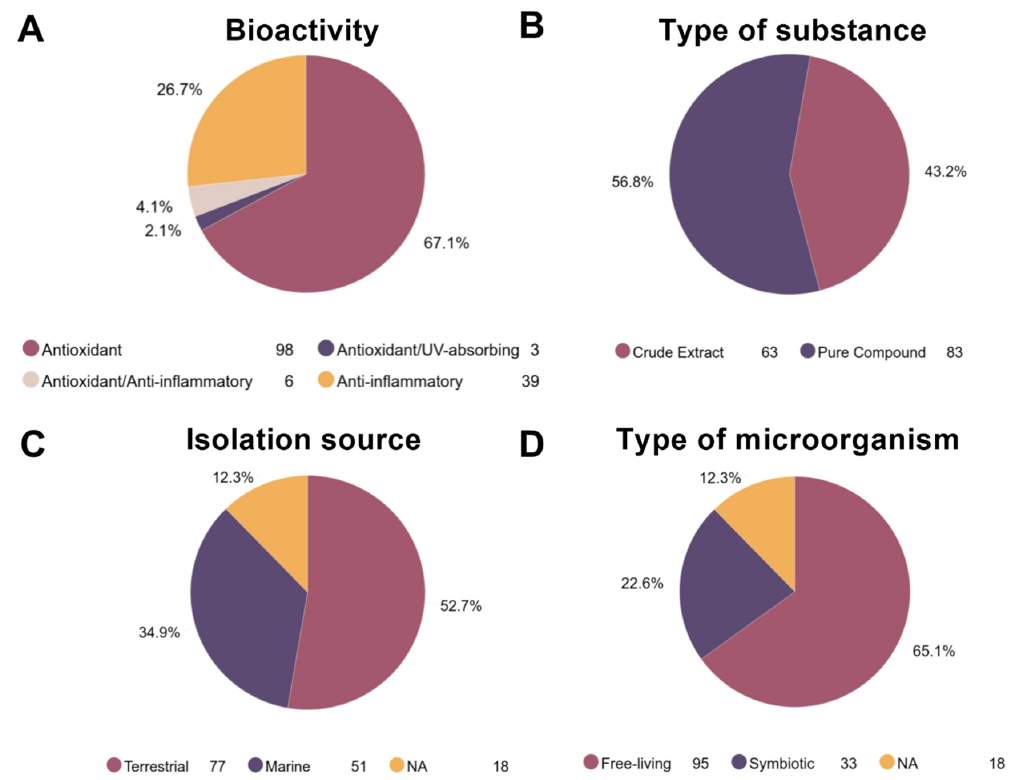
Figure 3. Characteristics of the information registered in the selected articles. The publications were grouped according to the information extracted for the analysis. ( A ) Percentage of articles by biological activity. ( B ) Percentage of articles that evaluated either crude extracts or pure compounds. ( C ) Percentage of articles by the environment where the isolation occurred (i.e., terrestrial, marine or not available). ( D ) Percentage of articles by the type of Streptomyces strain isolated (i.e., free-living, symbiotic or not available). At the bottom of each pie chart, the number of papers for each group is presented.